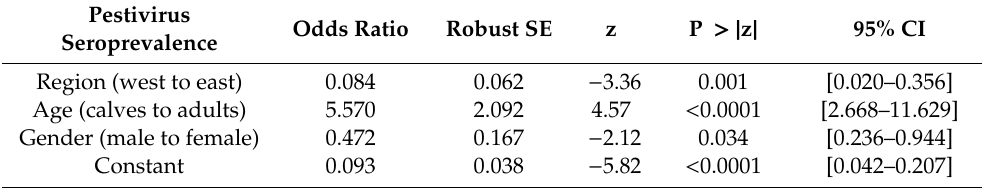
Table 3. Logistic regression model for risk factors associated with becoming infected with pestivirus.